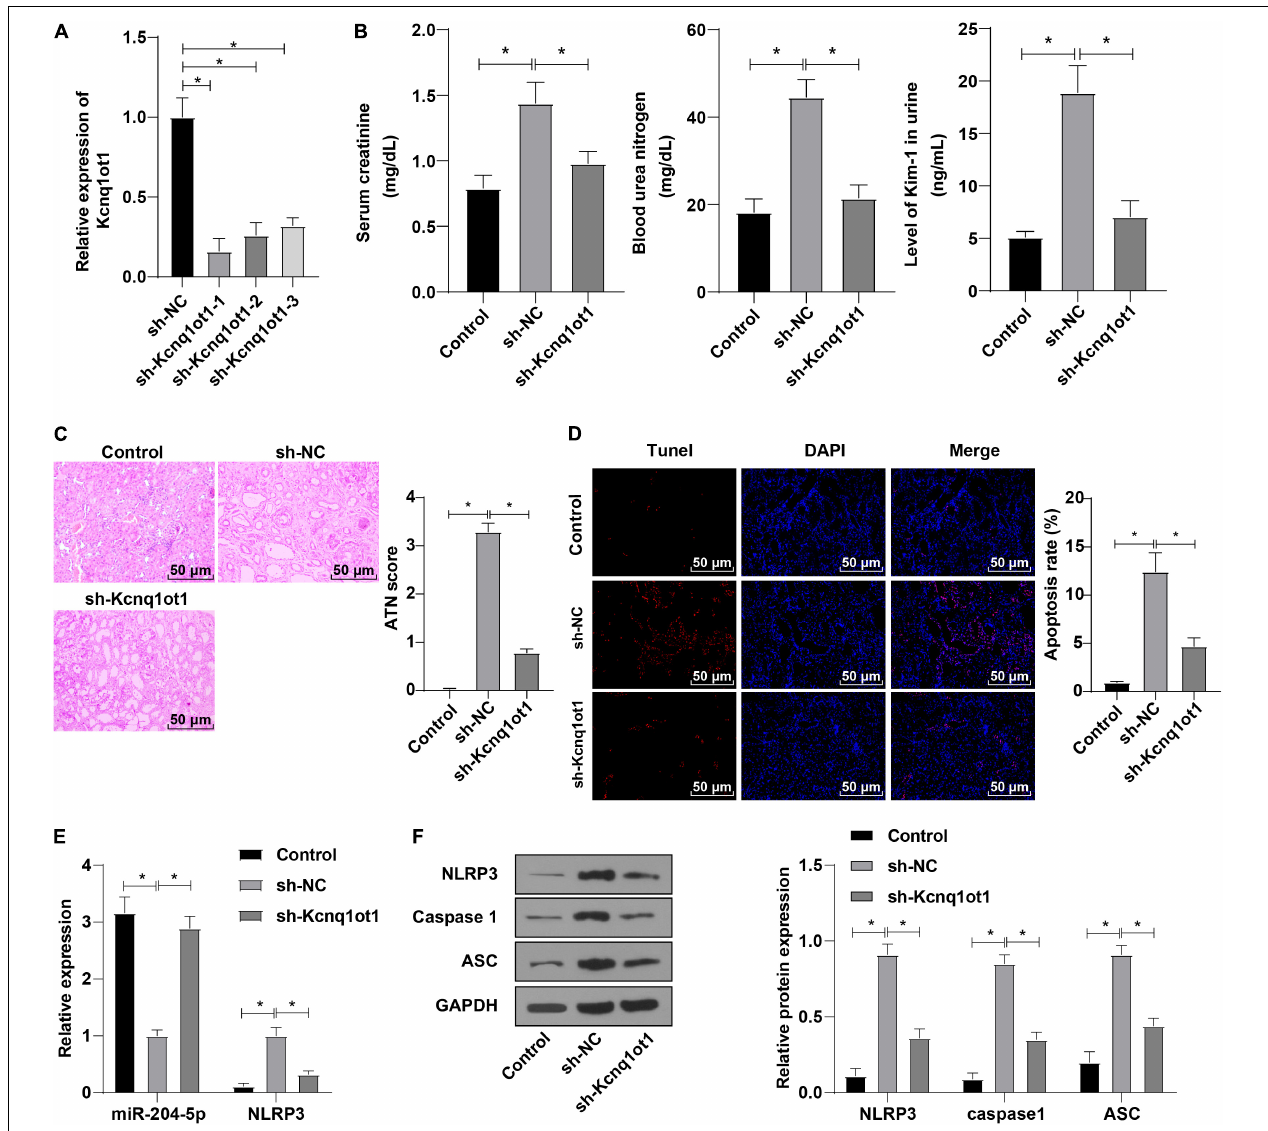
FIGURE 6 | In vivo knockdown of Kcnq1ot1 inhibited the progression of AKI by regulating the miR-204-5p/NLRP3 axis. (A) Transfection efficiency after interfering Kcnq1ot1 was detected by RT-qPCR; (B) levels of SCr, BUN, and KIM-1 in mouse serum were detected by ELISA; (C) pathological changes of renal tissues were detected by HE staining and tissue damage degree was statistically analyzed; (D) cell apoptosis in renal tissues was detected by TUNEL staining; (E) expressions of miR-204-5p and NLRP3 in renal tissues were detected by RT-qPCR; (F) levels of NLRP3, caspase1, and ASC in renal tissues were detected by Western blot. All data in this figure were measurement data and presented as M ± SD . Comparison between two groups was analyzed using an independent sample t -test. * P < 0.05. The experiment was repeated three